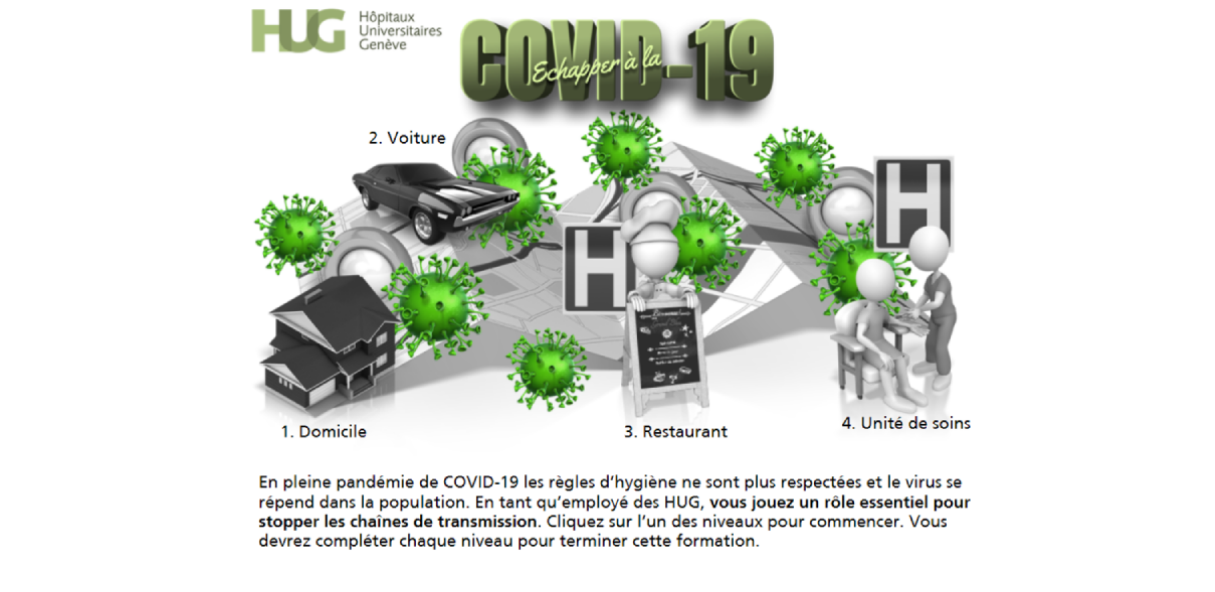
Figure 1. First version of the welcome